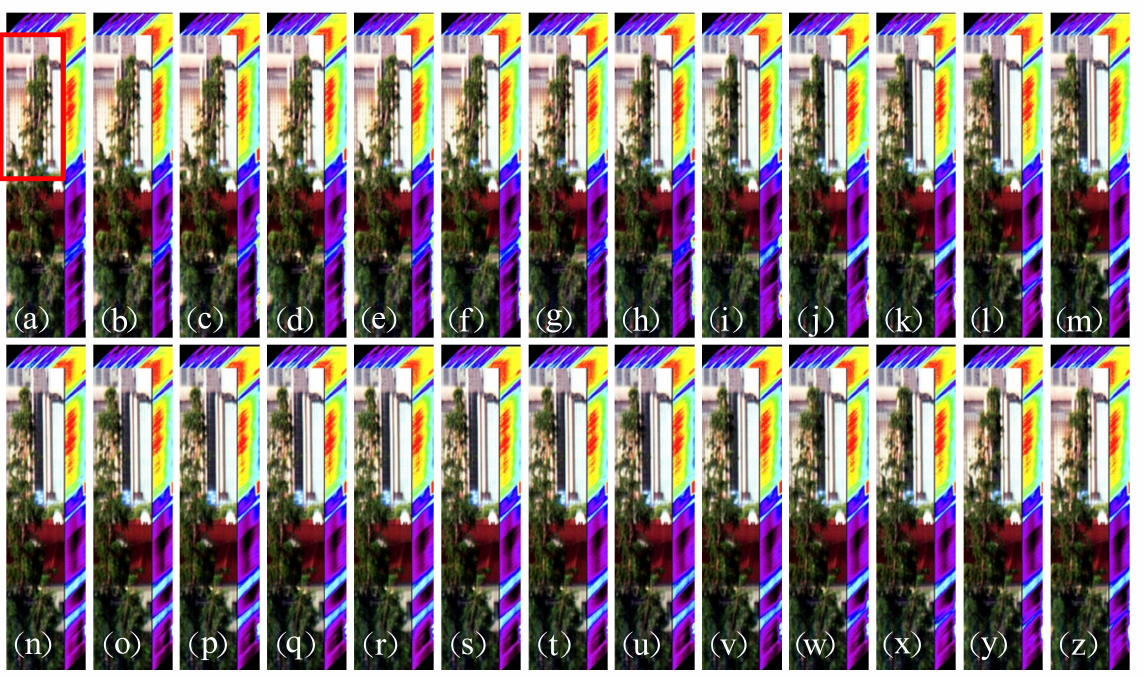
Figure 9. The 10 Hz frame rate for the spectral data recovery results of moving targets. ( a – z ) are the spectral data cubes acquired over a continuous period of 2.6 s. Reconstructed spectral data cubes are displayed by ENVI (The Environment for Visualizing